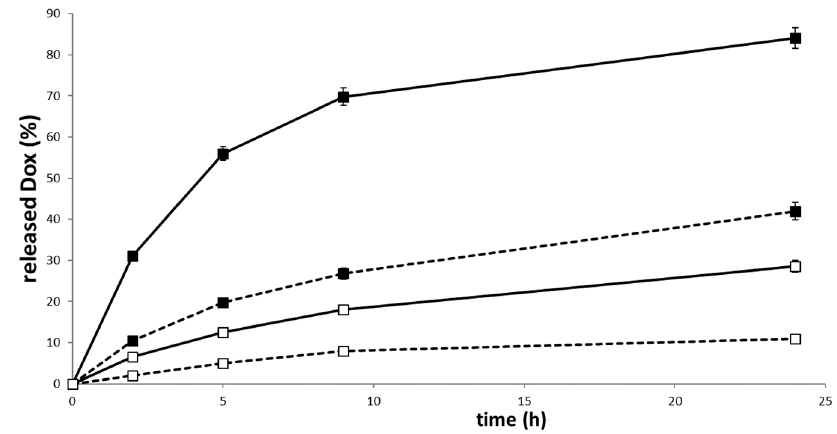
Figure 2. Release of free Dox from polymer conjugate at different pH levels at 37 °C for the indicated time periods. ( ■── ) pH 5.0; ( ■ - - -) pH 6.0; ( □ ─ ─ ) pH 6.5; ( □ - - -), pH 7.4.